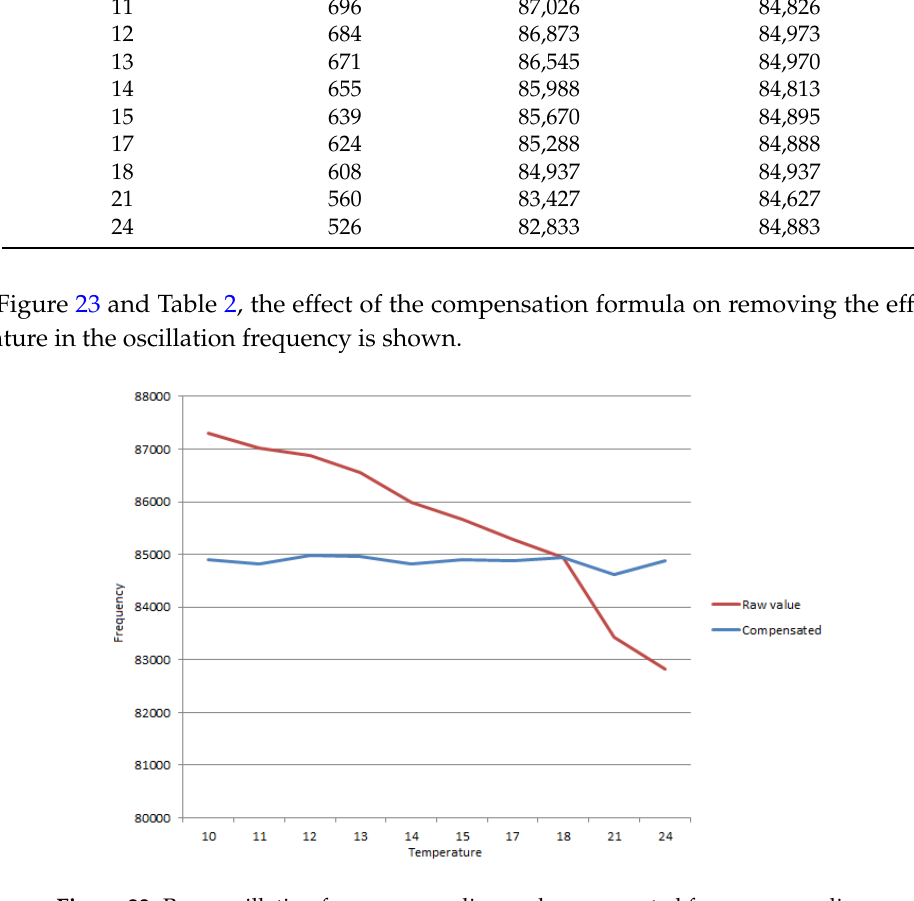
Figure 23. Raw oscillation frequency reading and compensated frequency reading.